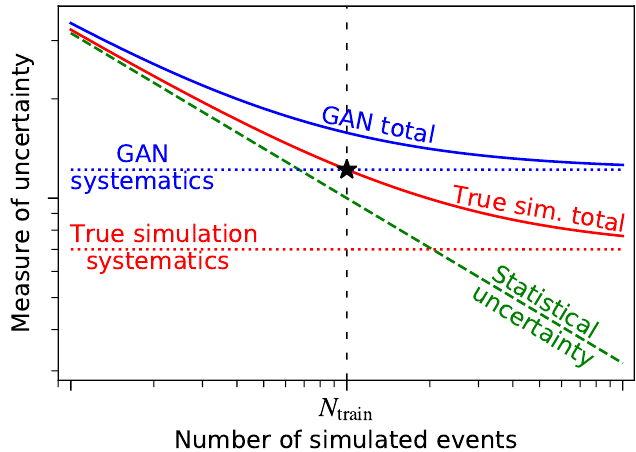
Figure 2: Typical evolution of various uncertainties with the number of simulated events. The green dashed line corresponds to the statistical uncertainty from simula- tion, while the red dotted and blue dotted lines represent the systematic uncertainty of the true simulation and the GAN simulation, respectively. The red (blue) solid line gives the total uncertainty of the true simulation (the GAN simulation), with the corresponding statistical and systematic uncertainties added in quadrature. We assume that the GAN is trained on a sample of N events, and as a result, the GAN- train generated data inherits the total uncertainty from the training sample as depicted by the (cid:198) symbol. For concreteness, the blue curves correspond to purely GAN-generated data, and not GAN-augmented